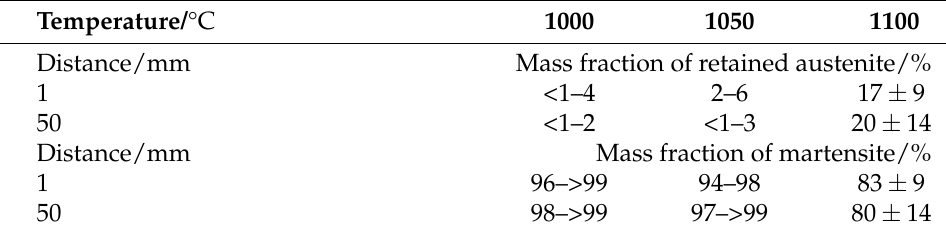
Figure 19. XRD pattern of the different Jominy end quench test specimens at different austenitizing temperature and distance from the quenched end face. The counts are plotted as a function of the angle 2 Θ . The postion of the phases austenite and martensite are marked. Table 8. Mass fractions of retained austenite and martensite phases of the Jominy end quench test specimens as a function of austenitizing temperature and distance from the quenched end face measured by XRD. Note that a quantification of the fractions of chromium carbides based on the XRD investigations was not possible due to their too low contents and densities. At 1050°C and 50mm distance to the quenched end face, as well as at 1000°C, the retained austenite content was in the first measurement below the detection limit of 1%. The standard deviation of the phase fractions for the samples austenitised at 1100°C results from the eight